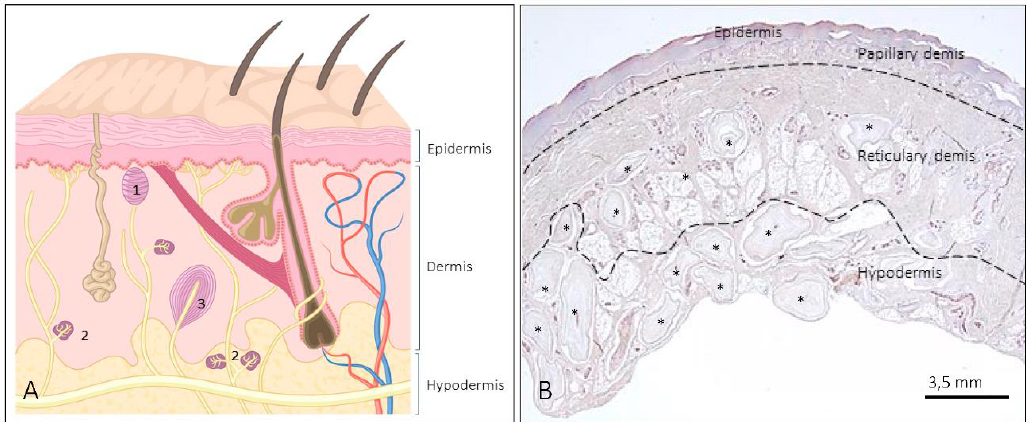
Figure 1. ( A ) Schematic representation showing the structure of the skin and the different morphotypes of sensory corpuscles. 1: Meissner corpuscles; 2: Ruffini corpuscles; 3: Pacini corpuscles; ( B ) low magnification of a histological section of human digital skin. The lines indicate the approximate limits of the three skin layers (epidermis, dermis—papillary and reticular—and hypodermis). Both the dermis and hypodermis contain abundant sensory corpuscles. * denotes Pacinian corpuscles.